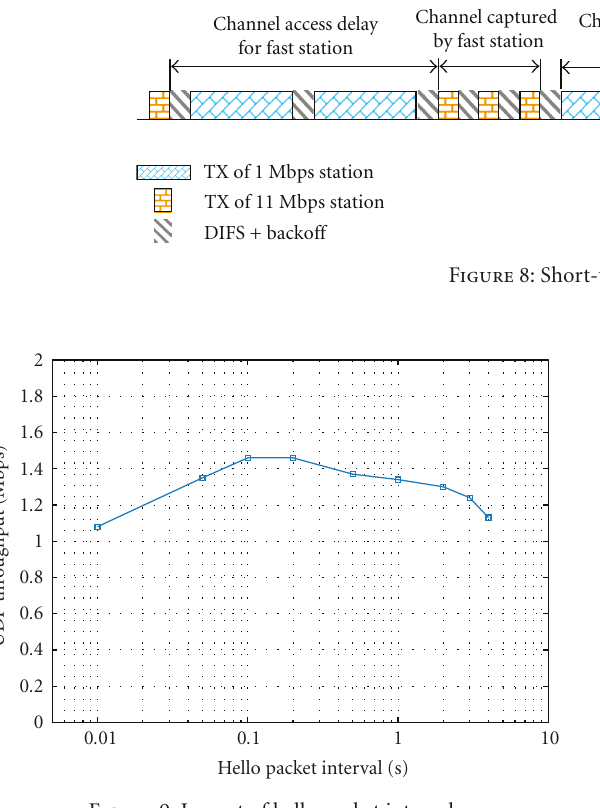
Figure 9: Impact of hello packet interval.